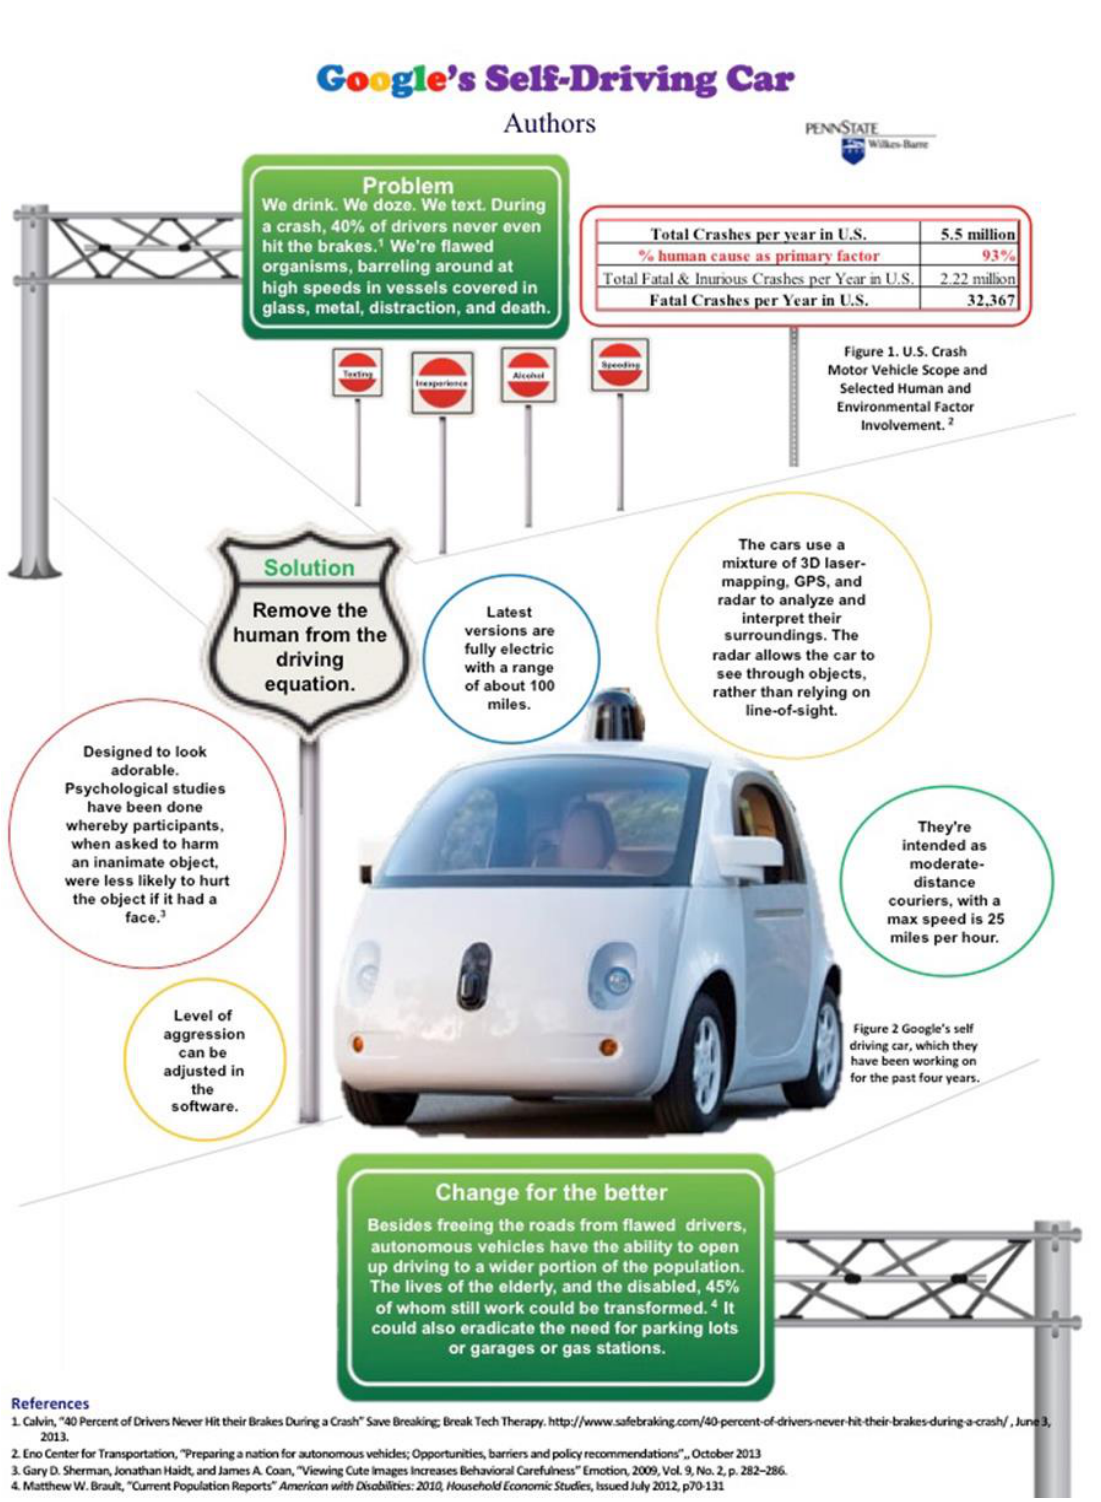
Figure 3 Final draft of “Google’s Self-Driving Car” poster with portrait orientation and less